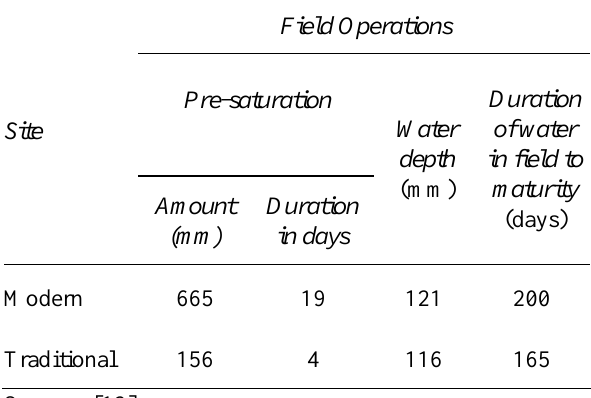
Table 4: Field operation and water use for the different